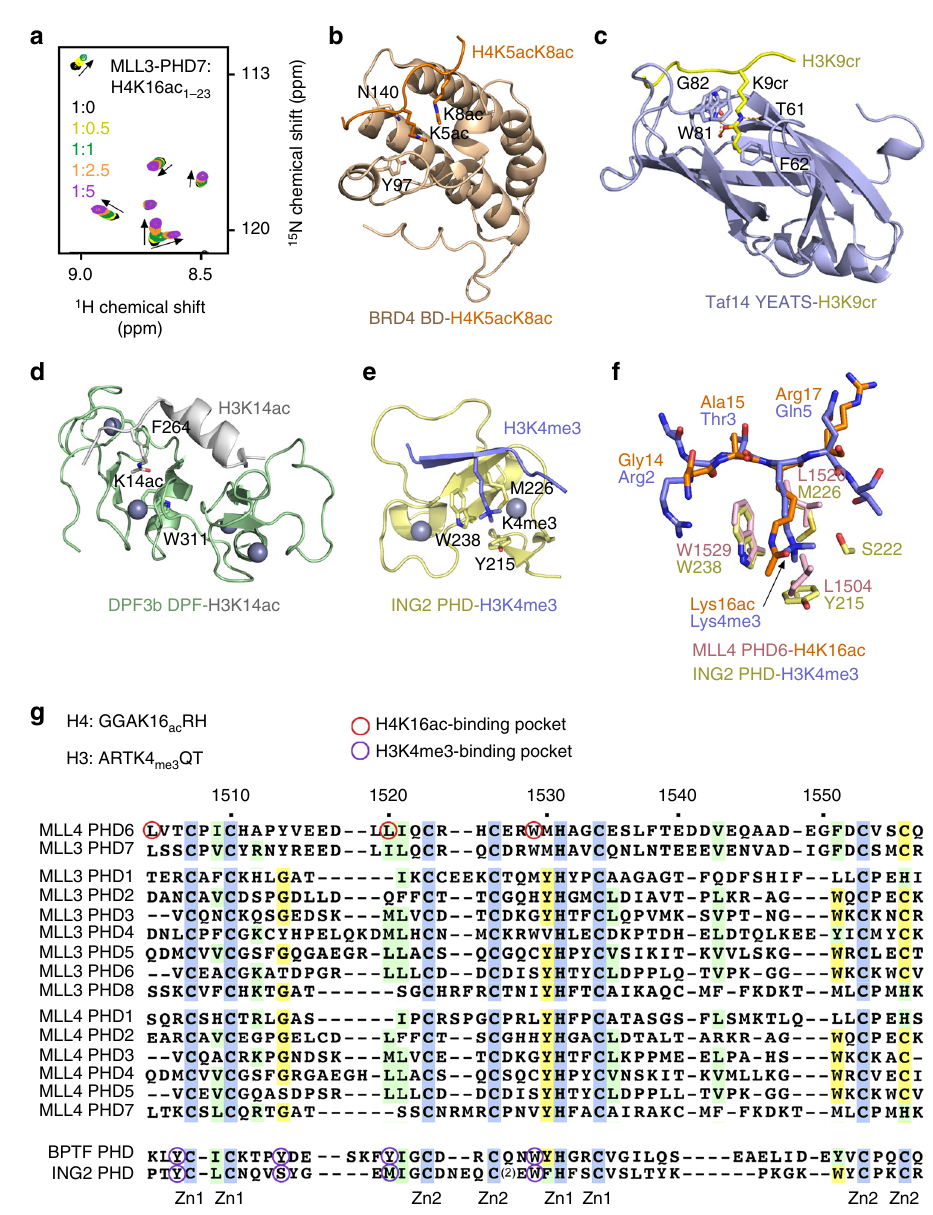
Fig. 7 Comparative analysis of the H3K4me3 and H4K16ac recognition by histone readers. a Superimposed 1 H, 15 N heteronuclear single quantum coherence spectra of MLL3-PHD7 1083 – 1143 collected upon titration with H4K16ac peptide. Spectra are color coded according to the protein:peptide molar ratio. b – d Structures of the BRD4 BD, Taf14 YEATS, and DPF3b DPF readers in complex with the indicated histone peptides 24,50,51 . PDB IDs: 3UVW ( b ), 5IOK ( c ), and 5I3l ( d ). e Structure of the ING2 PHD fi nger in complex with H3K4me3 30 . PDB ID: 2G6Q. f A zoom-in view of the overlaid histone tail- binding sites of the ING2 PHD-H3K4me3 and MLL4 PHD6-H4K16ac complexes. g Alignment of amino acid sequences of the PHD fi ngers from human MLL4, MLL3, BPTF, and ING2. Absolutely, moderately, and weakly conserved residues are colored blue, green, and yellow, respectively. Zinc-coordinating cysteine/histidine residues are mutants were generated by site-directed mutagenesis using the Stratagene Quik- Change mutagenesis protocol, grown, and puri fi ed as WT proteins. peptide (Supplementary Fig. 6). Backbone chemical shift assignments for the apo- state were obtained through 1 H, 15 N HSQC titration experiments using backbone chemical shift assignments for the H4K16ac-bound MLL4 PHD6 fi nger. Three- NMR experiments . NMR experiments were carried out at 298 K on Varian dimensional (3D) 15 N- and 13 C-edited NOESY-HSQC spectra (mixing time of INOVA 600 and 900 MHz spectrometers. NMR samples for structure determi- 100 ms) were collected to obtain distance restraints. Two-dimensional (2D) 15 N-/ nation were prepared in 20mM Tris-HCl (pH 7.0) buffer, supplemented with 13 C- fi ltered NOESY-HSQC and TOCSY-HSQC spectra were collected to obtain 100 mM NaCl, 5 mM DTT, and 8% D 2 O. Backbone and side chain chemical shift chemical shift assignments for the H4K16ac peptide. NMR experiments, including assignments for the H4K16ac-bound MLL4-PHD6 fi nger were obtained by col- 2D NOESY, TOCSY, and reverse HSQC titration experiments, were performed on lecting and processing a set of triple resonance experiments (HNCACB, CBCA (CO)NH, CC(CO)NH, HBHA(CO)NH, HNCA, H(CCO)NH) 39 with Non Linear Sampling 40 . Chemical shift assignments were obtained for 96% of backbone amides (minus proline residues). The NMR sample contained 2.5mM 13 C/ 15 N-labeled MLL4-PHD6 and 7.5mM H4K16ac (11 – 21) peptide (the 3-fold excess of peptide